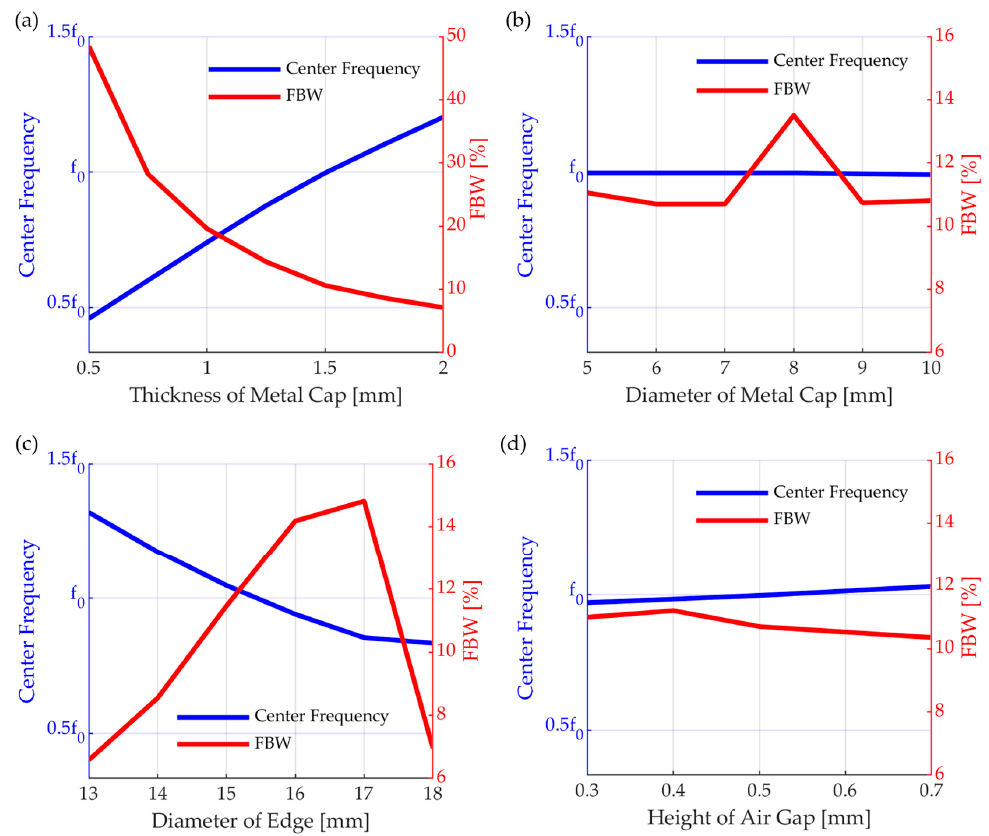
Figure 10. Acoustic properties of a cymbal transducer according to various parameters ( a ) t b , ( b ) r a , ( c ) r b , and ( d ) h A